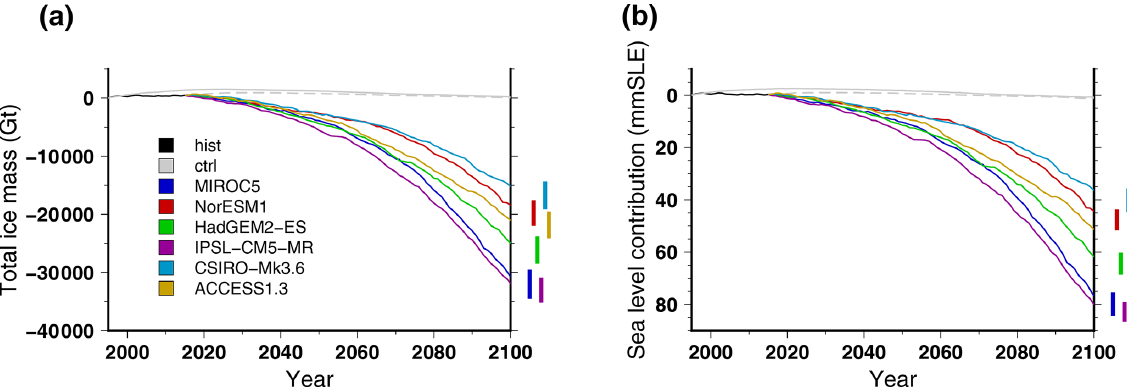
Figure 4. Simulated total ice mass change for the historical simulation hist (1995–2015), the control experiments ctrl (solid grey lines) and ctrl_proj (dashed grey lines) and the projections under the different CMIP5 forcings using the RCP8.5 scenario and the medium oceanic sensitivity: (a) total mass change and (b) ice volume contributing to sea level rise. For each projection experiment, the right-hand-side vertical bar shows the minimal and maximal changes associated with the oceanic-forcing uncertainty ( low and high scenarios).